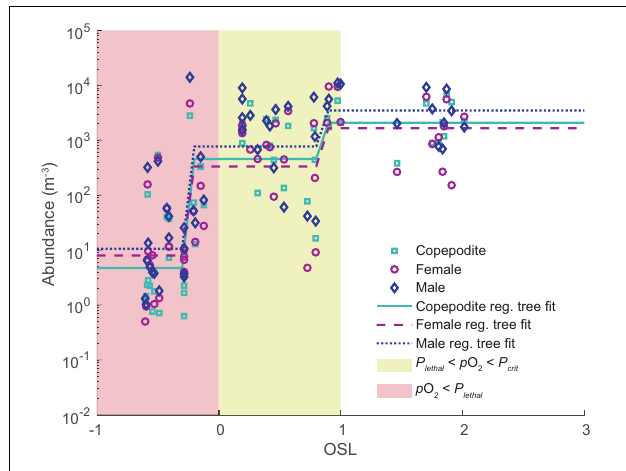
FIGURE 8 | Concentration (m − 3 ) of Acartia tonsa in the Chesapeake Bay at various values of OSL, determined from simultaneously collected vertically stratified zooplankton samples and hydrographic data. Green squares show data for copepodite stages, purple circles show data for adult females, and blue diamonds show data for adult males. Lines show results from regression tree analysis to examine the relationship between log10 transformed concentration and OSL, with solid green lines for copepodites, dashed purple lines for adult females, and dotted blue lines for adult males. Yellow shaded area shows where P leth < pO 2 < P crit , and pink shaded region shows where pO 2 < P leth . Regression trees were created in Matlab using the “fitrtree.m” function, with a minimum leaf size of 8 and pruned to a level of